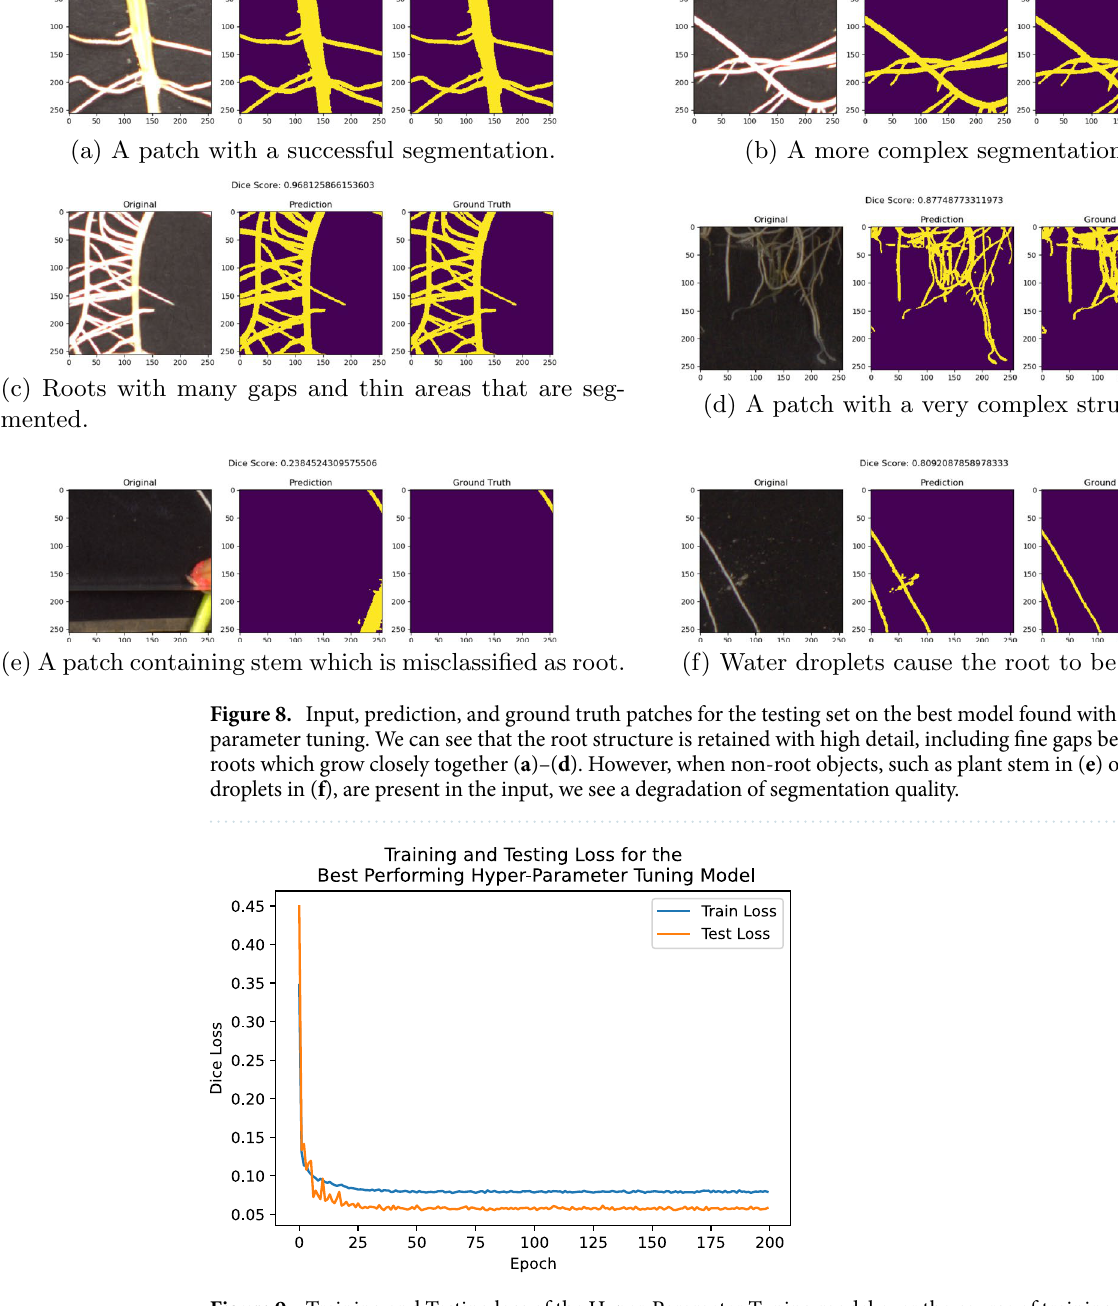
(a) A patch with a successful segmentation. (b) A more complex segmentation.